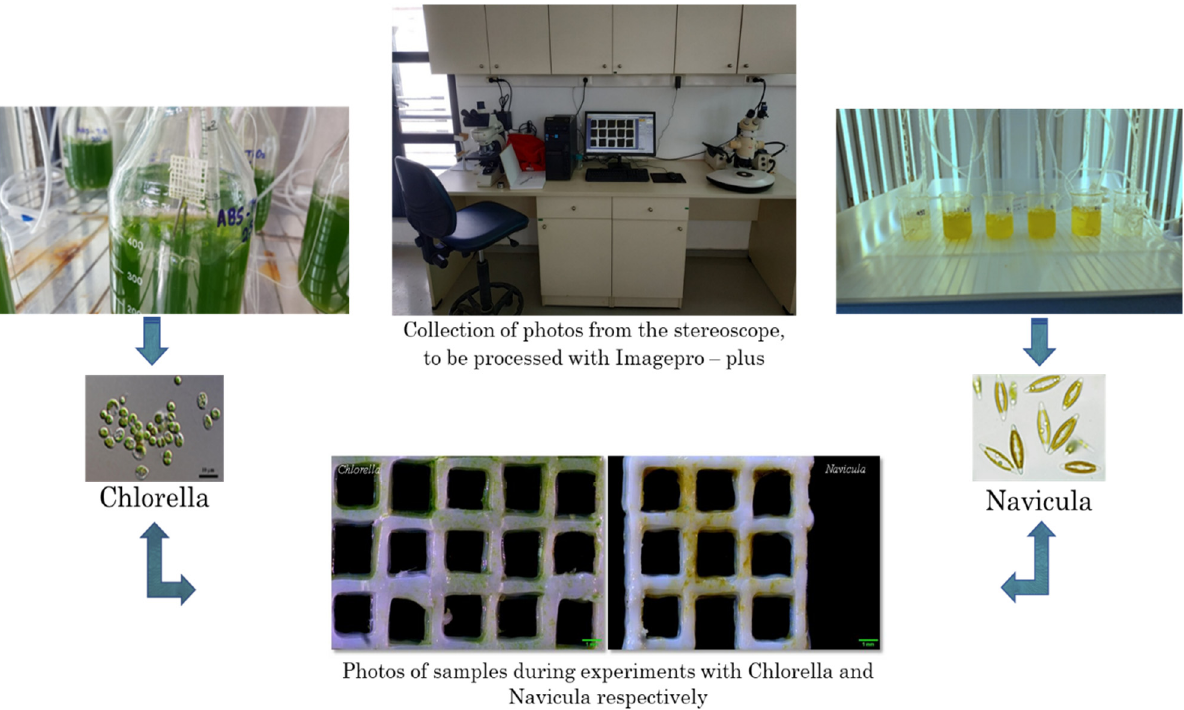
Figure 2. Schematic presentation of experiments for the investigation of the antifouling action.